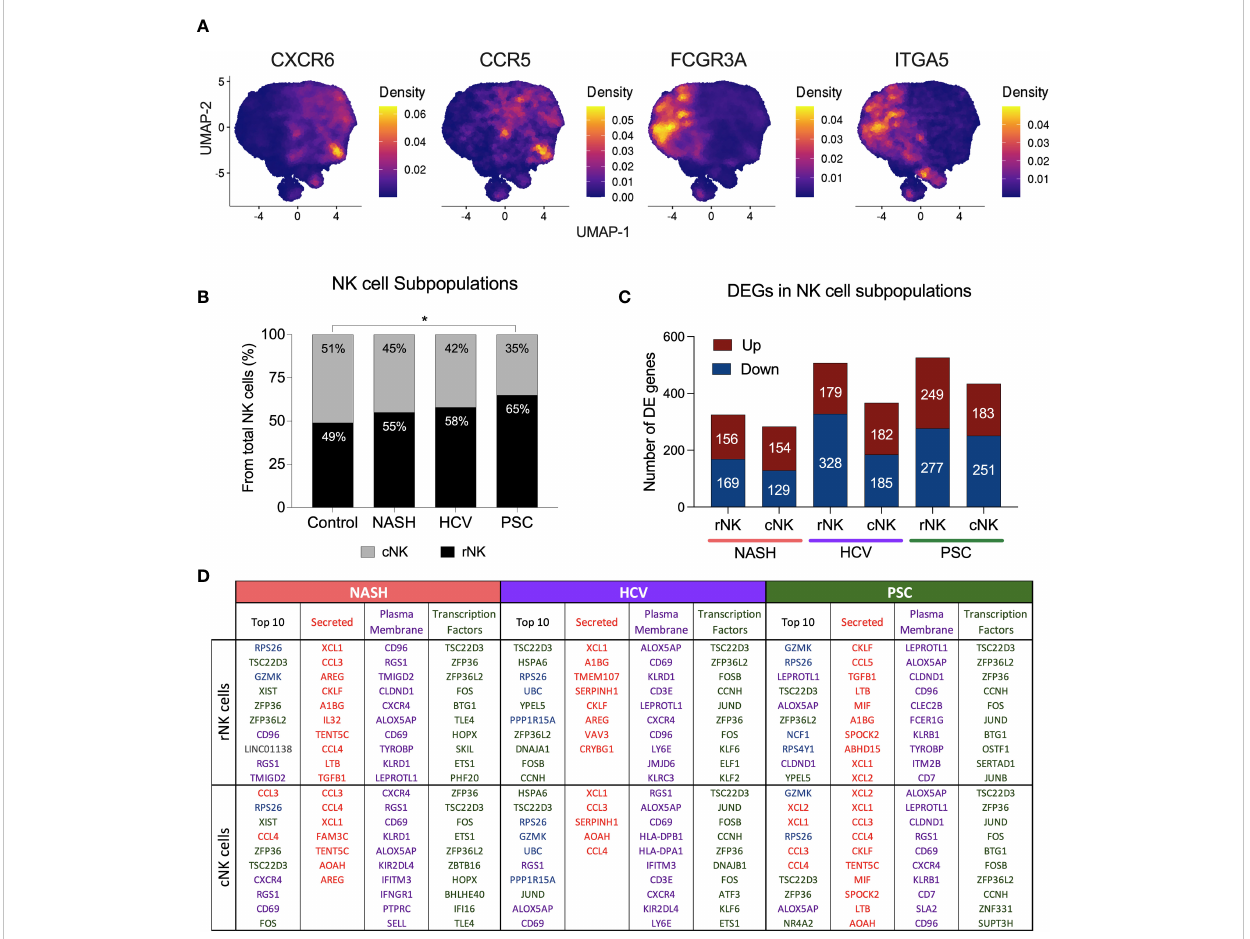
FIGURE 3 Hepatic Resident and In fi ltrating NK cells pro fi ling in end-stage chronic liver diseases. (A) UMAPs showing the density of cells expressing CXCR6, ITGA5 (CD49e), CCR5 and FCGR3A (encoding CD16). NK cells CXCR6 + CCR5 + ITGA5 - and FCGR3A - are identi fi ed as resident NK cells (rNK), and NK cells FCGR3A + ITGA5 + CXCR6 - CCR5 - are classi fi ed as conventional in fi ltrating NK cells (cNK). (B) Analysis of cNK/rNK cells frequencies in the 4 groups indicated an increase of rNK subpopulation in cirrhotic livers. The PSC group has signi fi cantly more rNK cells than the healthy group (* p<0.05). (C) Numbers of differentially expressed (DE) genes found in each subpopulation among diseases. (D) Top ten most highly expressed DE genes in hepatic rNK and cNK cells from NASH, HCV, and PSC subjects. Upregulated genes were ranked by P-value among the total gene set and among genes encoding secreted proteins, plasma membrane proteins and transcription factors. Secreted proteins were color-coded in red, plasma membrane protein-encoding genes are purple, transcription factor-encoding genes are green, genes encoding cytoplasmic protein are in blue and genes encoding other proteins are